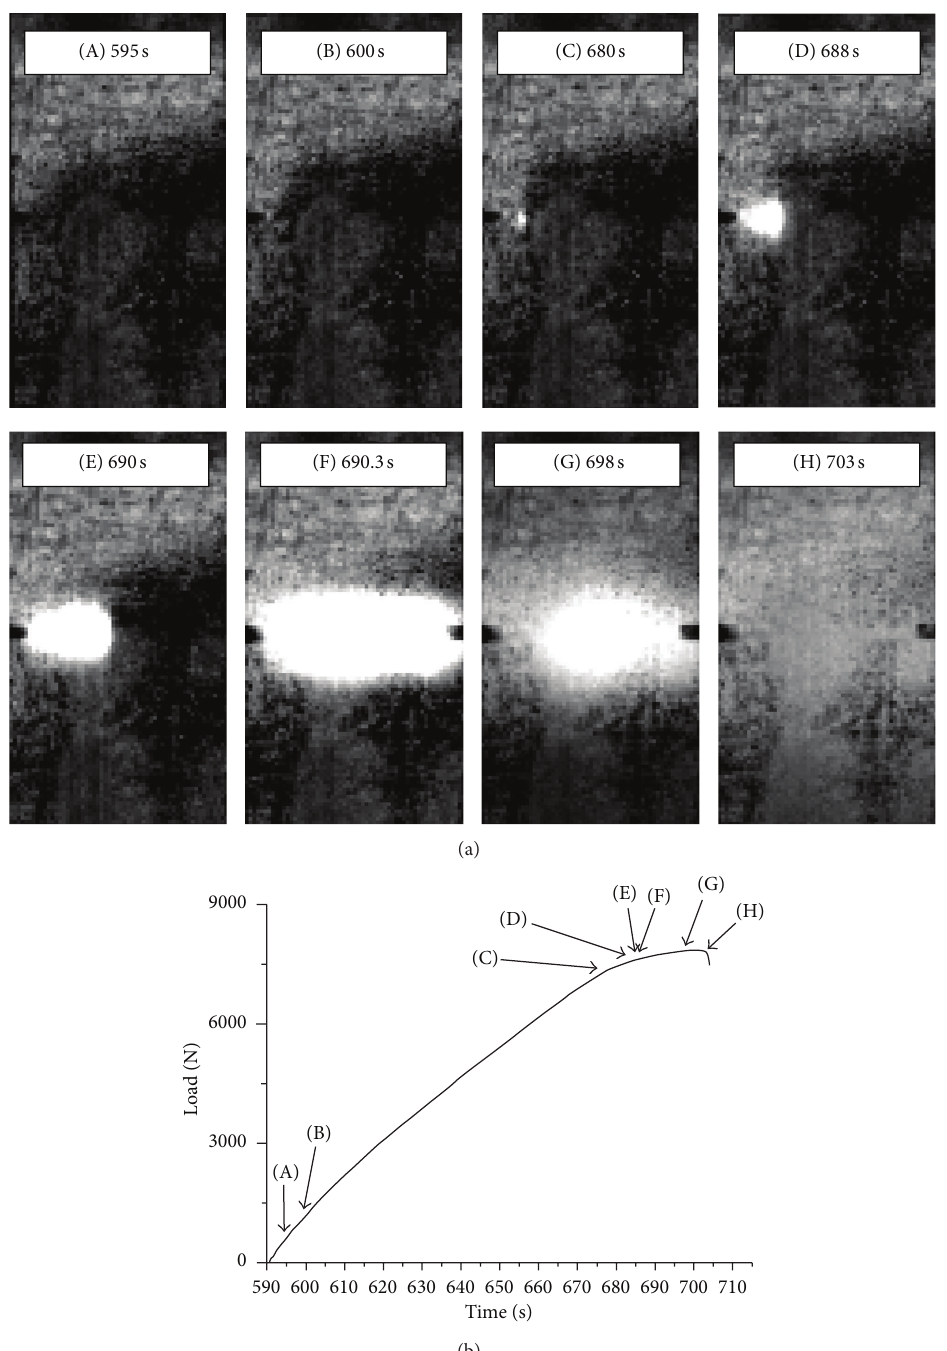
Figure 6: ((a), (b)) Thermographs of crack propagation and diagram of load versus time of final loading cycle (0.2 notch-to-width ratio